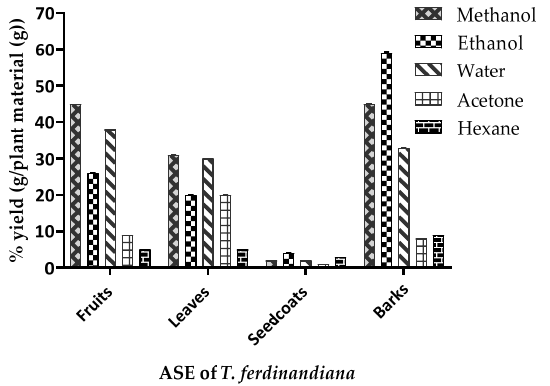
Figure 2. Yield (%) of the accelerated solvent extraction (ASE) of Terminalia ferdinandiana . Results are shown as the mean of triplicate experiments ± SD.